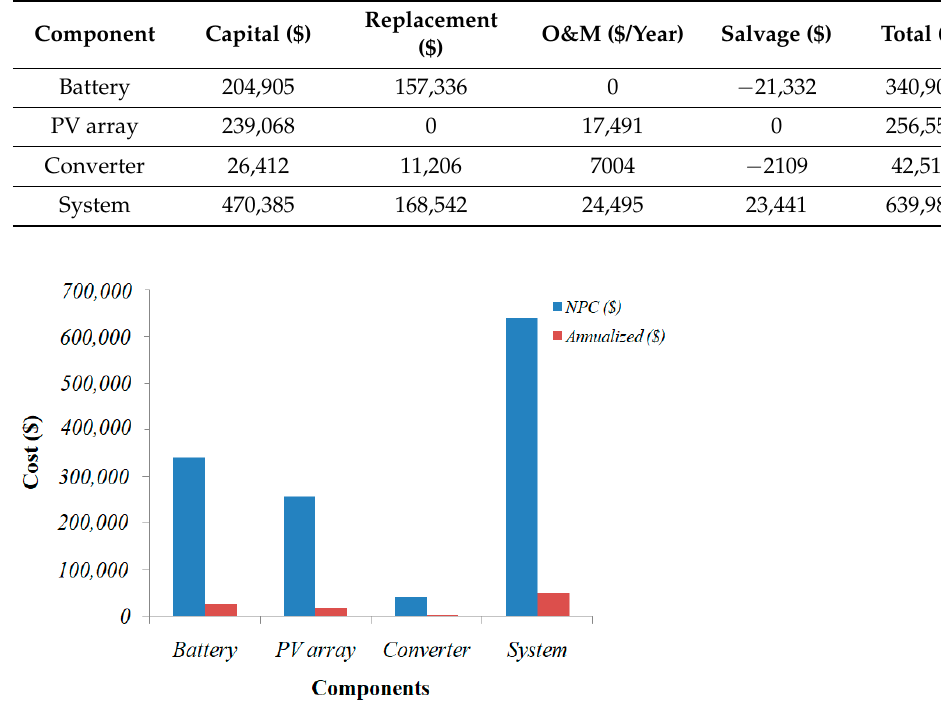
Figure 14. Cost summary of the components in PV–BSS configuration.